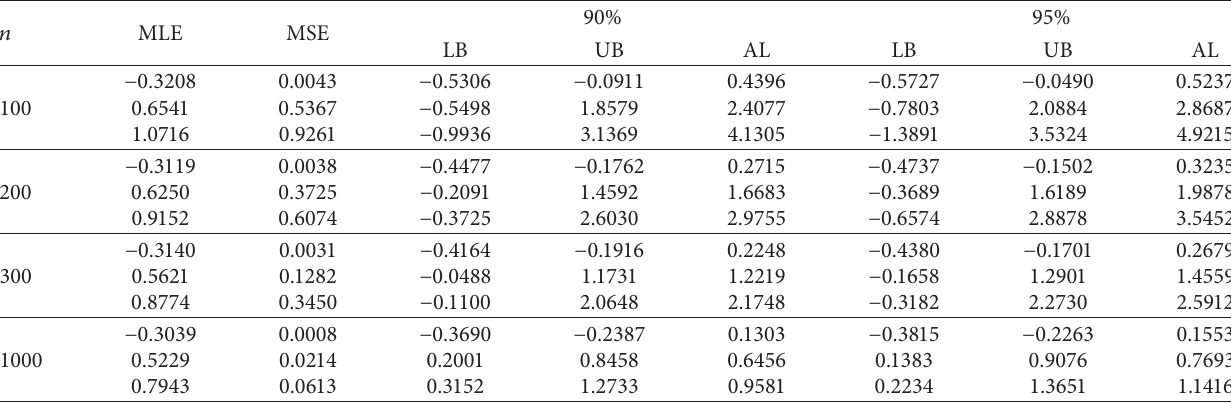
Table 6: Values of the MLEs, MSEs, and elements of CIs associated with the NTMW model parameters for Set2.